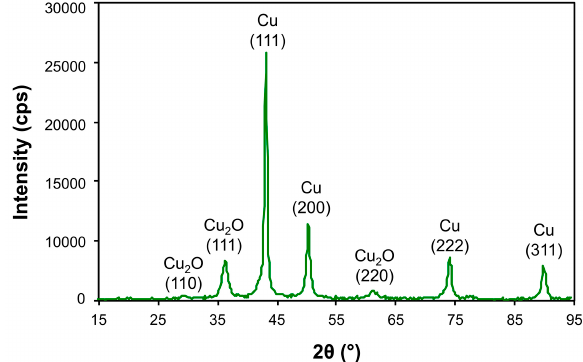
Figure 6. Example of the XRD of a Cu-SWCNT composite prepared by electroless deposition after a reaction of 15 min, showing the presence of Cu (ICDD #04-009-2090) and Cu 2 O (ICDD #04-002-3214). Table 6. Chemical composition and crystal grain size as determined by XRD for Cu–SWCNT